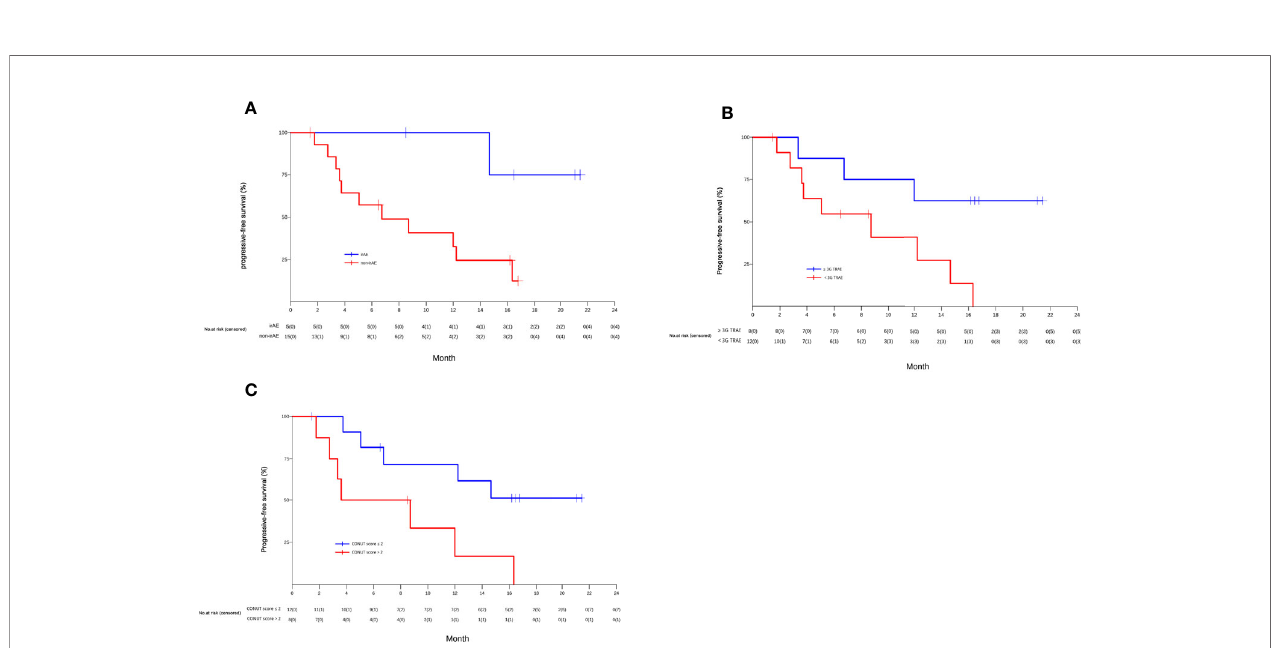
FIGURE 4 | The Kaplan-Meier curves of PFS of unresectable or metastatic hepatocellular carcinoma patients in the ef fi cacy-evaluable population strati fi ed by the presence or absence of immune related-adverse events (irAEs) (A) , grade 3 treatment-related adverse events (TRAEs) (B) , and baseline controlling nutritional status (CONUT) score (> 2 vs. ≤ 2) (C)